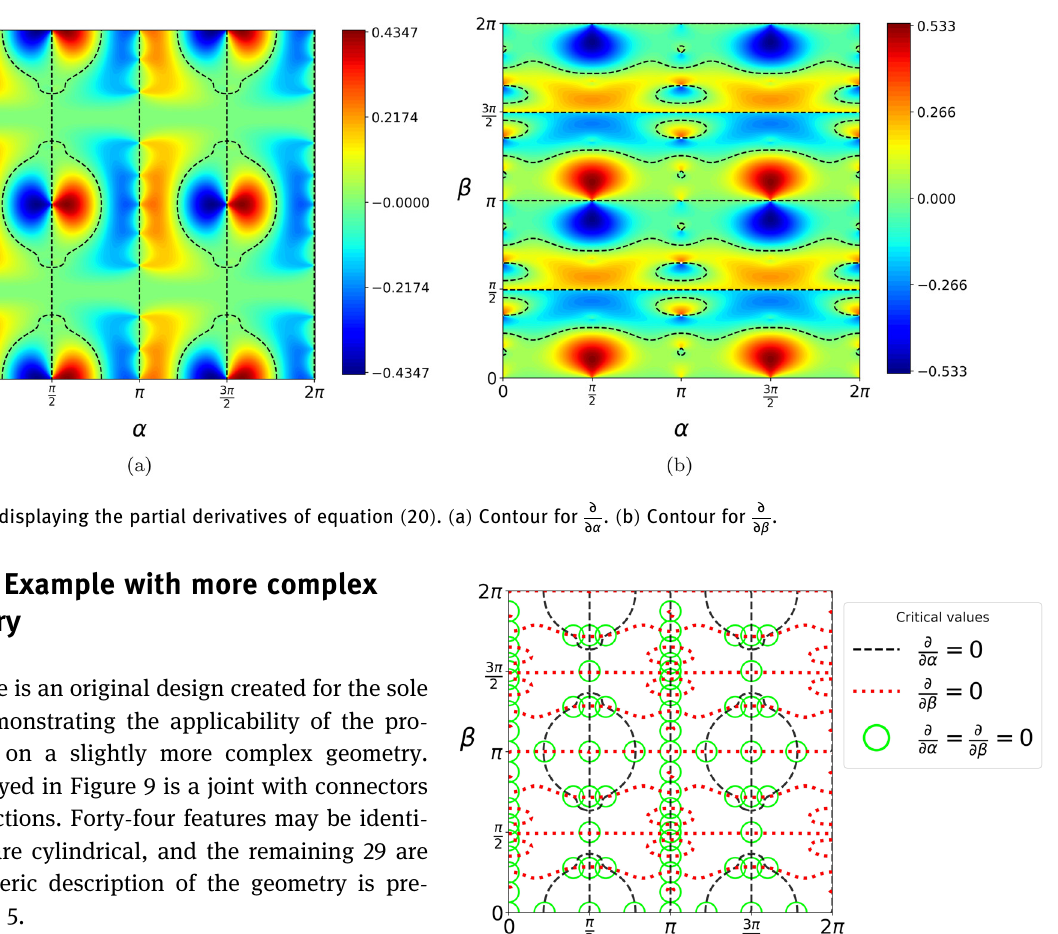
Figure 12: Contour lines for the partial derivatives of equation ( 20 )